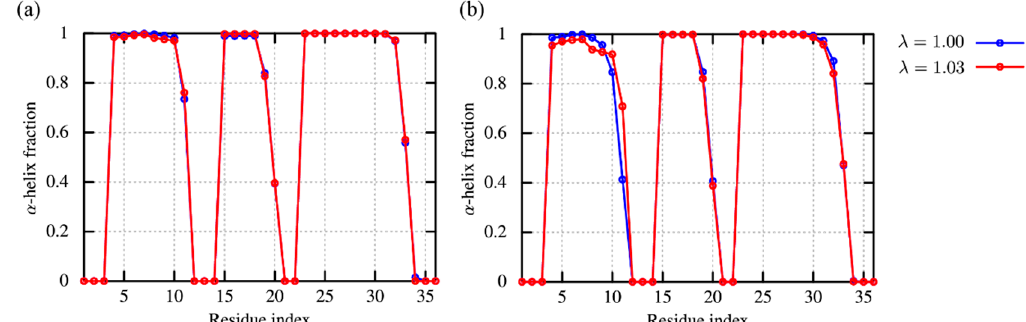
Figure 6. The 𝛼 -helix fraction of villin in the dilute ( a ) and crowded solutions ( b ). The fraction is computed through DSSP algorithm. As for the crowded solution, the averages of the fraction over eight villins are shown.